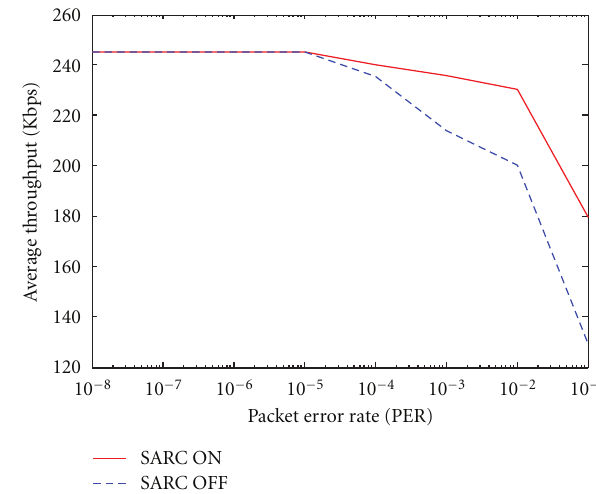
Figure 9: Average TCP Throughput as a function of Packet Error Rate on the wireless channel.